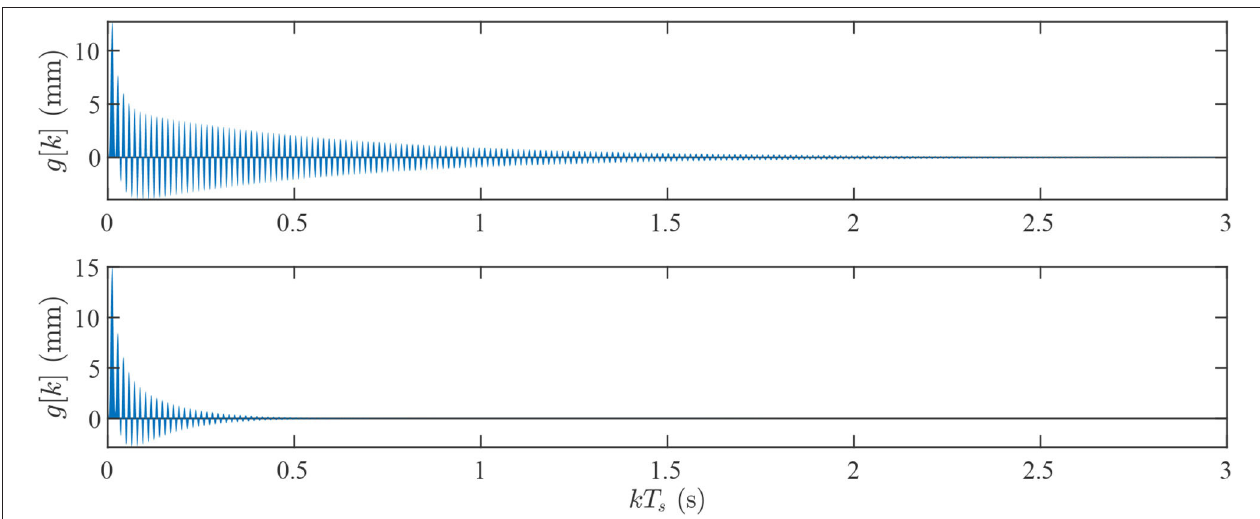
FIGURE 6 | Control plant’s impulse response. Upper: 4th-order Runge-Kutta integration. Lower : zero-order hold discretization of Equation (35). Rate fixed in both cases at F s = 4096 Hz.